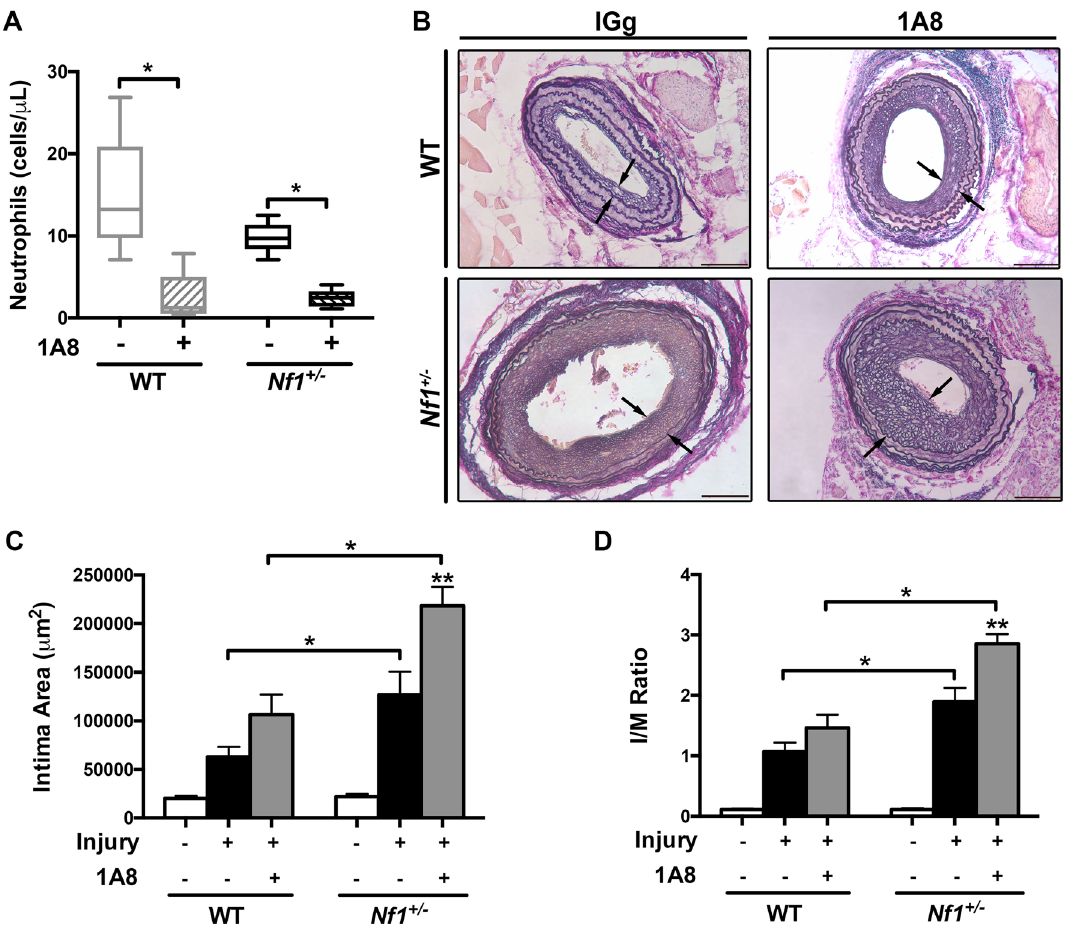
Figure 3. Neutrophil depletion increases neointima size in WT and Nf1 +/– mice . ( A ) quantification of neutrophils after administration of 1A8 to WT (gray) and Nf1 +/– (black) mice. * P < 0.01 for each